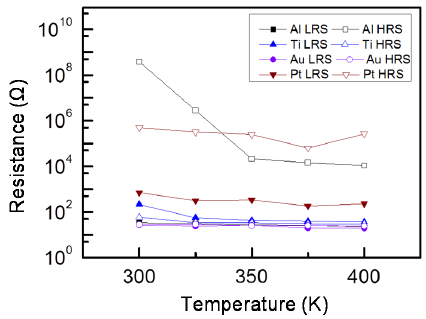
Figure 5. Temperature ‐ dependent resistance of STN memory devices measured between 300 and 400 K.